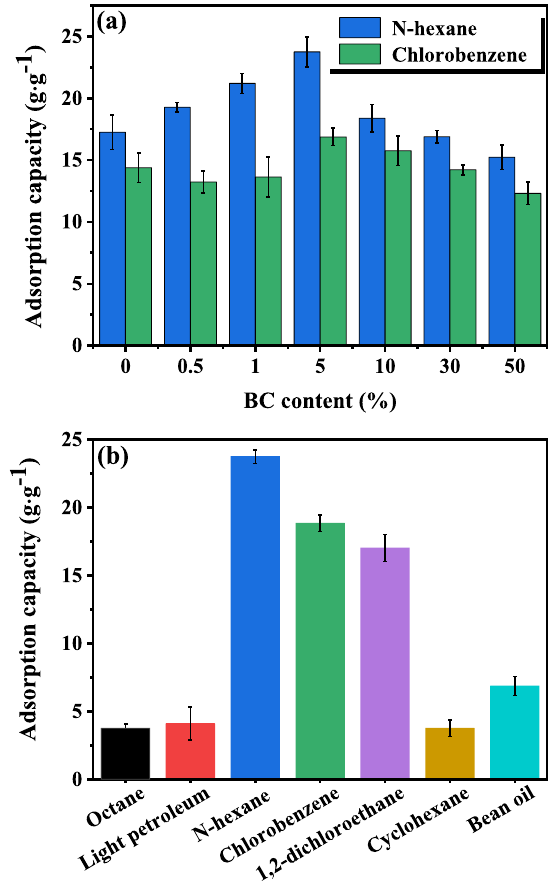
Fig. 4 Adsorption properties of BC/PU foam composites affected by the wt% of BC ( a ) and adsorption properties of the BC/PU-5 foam composites for OSs ( b ) (foam sample of 1 g, OSs concentration 100 mg·L −1 , 30 ℃ , and pH